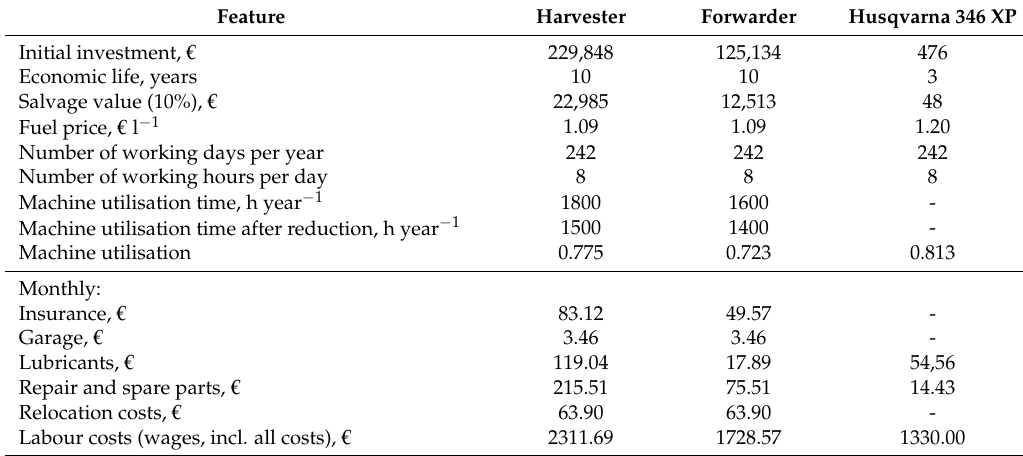
Table 4. General data for cost